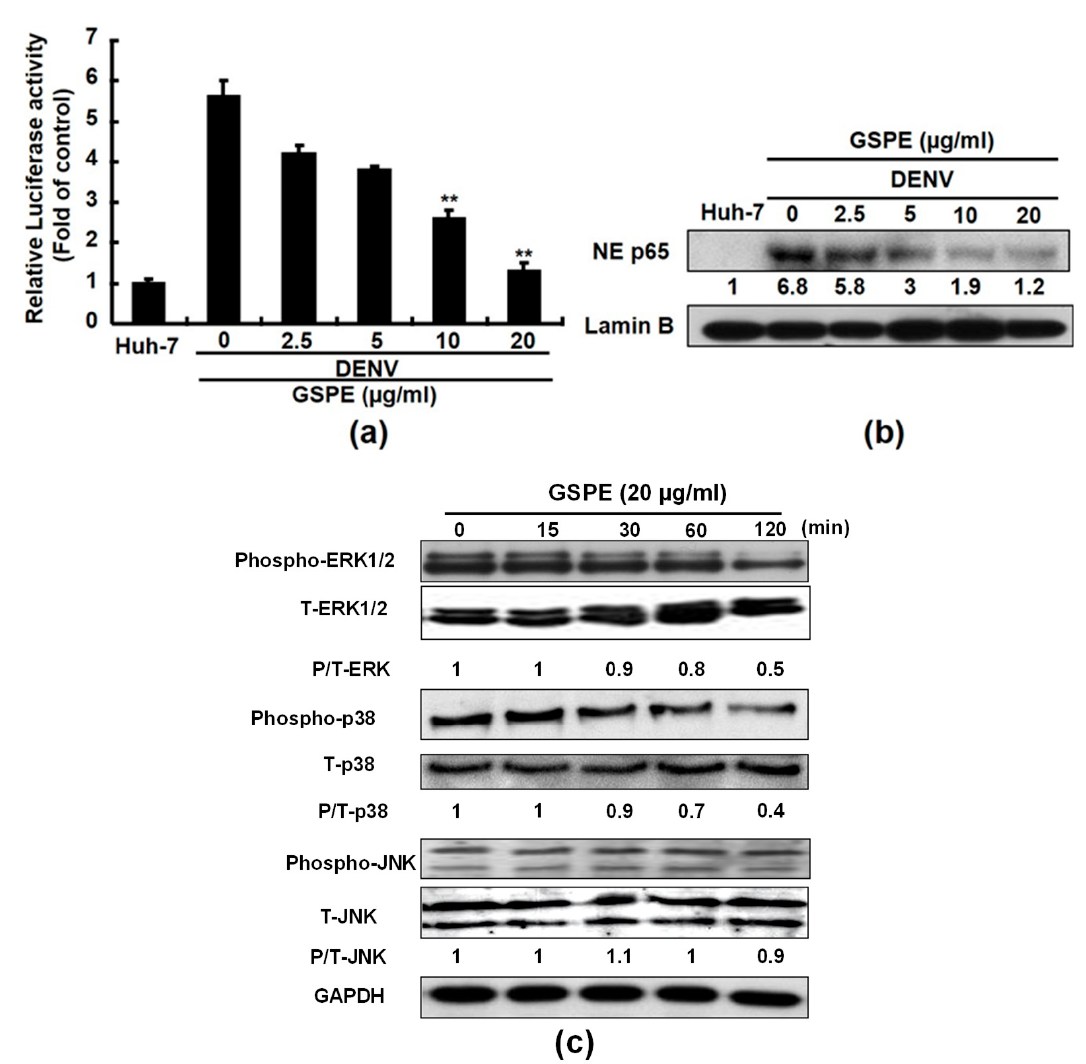
Figure 4. GSPE suppresses COX-2 expression by limiting NF-B transactivity and MAPK phosphorylation in DENV-infected Huh-7 cells. ( a ) GSPE decreased NF- κ B transactivity in Huh-7 cells. Huh-7 cells were transfected with the pNF- κ B-Luc reporter plasmid. The pNF- κ B-Luc-transfected cells were infected with DENV-2 at an MOI of 0.1 for 2 h and then treated with 20 µ g/mL of GSPE for 3 days. NF- κ B transactivity was analyzed by a luciferase activity assay. Relative NF- κ B transactivity is presented as a fold change compared to the parental Huh-7 cells in which luciferase activity was 1. ( b ) The GSPE treatment downregulated nuclear translocation of the p65 NF- κ B subunit. DENV-infected Huh-7 cells were treated with different concentrations (2.5–20 µ g/mL) of GSPE for 3 days. Nuclear translocation of NF- κ B was analyzed by western blotting with anti-phospho-p65 and anti-lamin B (loading control) antibodies. NE indicates the nuclear extract fraction. ( c ) The GSPE treatment reduced the ERK and p38 phosphorylation levels. DENV-infected Huh-7 cells were treated with 20 µ g/mL of GSPE and the lysates were extracted at the indicated time points after the treatment. Protein expression was analyzed by western blotting using antibodies against MAPK (ERK1/2, p38, and JNK), phospho-MAPK (p-ERK1/2, p-p38, and p-JNK), and GAPDH (loading control). “0” indicates the treatment with 0.1% DMSO. The relative protein levels were presented as fold-change values compared to the GSPE-untreated/non-DENV-infected Huh-7 cells. Data are presented as mean ± SD of three independent experiments. ** p <